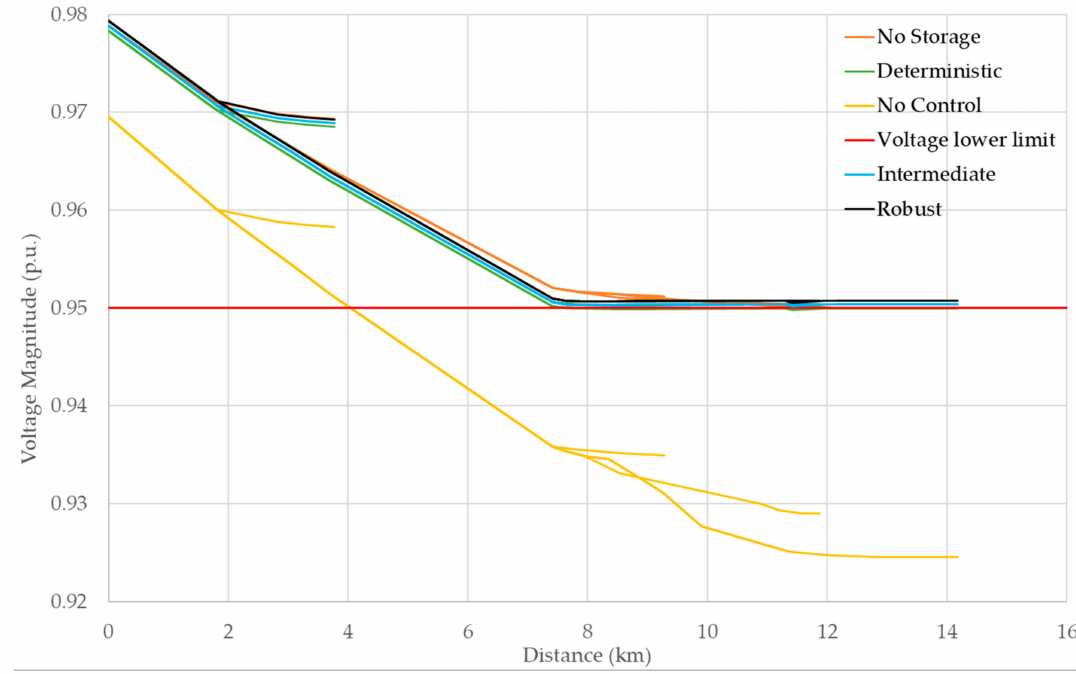
Figure 3. Voltage profiles of feeder F1 for no control, no storage (certain deterministic optimal power flow (OPF) without storage) and deterministic (certain deterministic OPF with storage), intermediate and robust cases at 9:00 am of the winter working day.